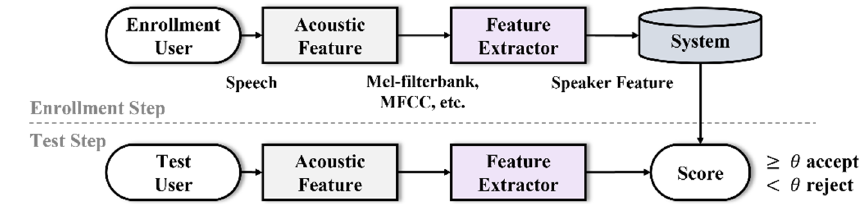
Figure 1. Block diagram of speaker verification system.